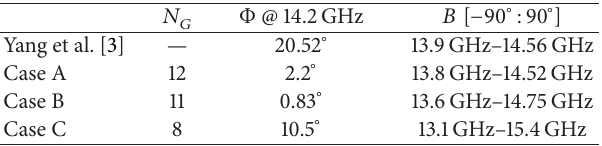
Figure 10: Geometry of the best individual for the 5 GHz EBG. Table 2: Comparison between the periodic structures derived from the best individuals shown in Figures 5, 6, and 7.